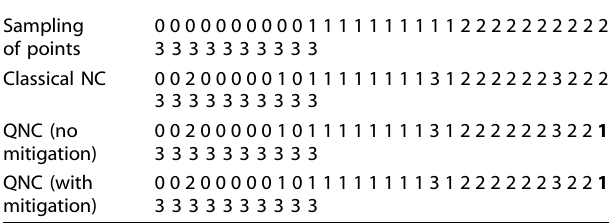
Table 1. Comparison of labels assigned by the different classi fi cation schemes for synthetic data with N q = 4, N c = 4, and N s = 500.